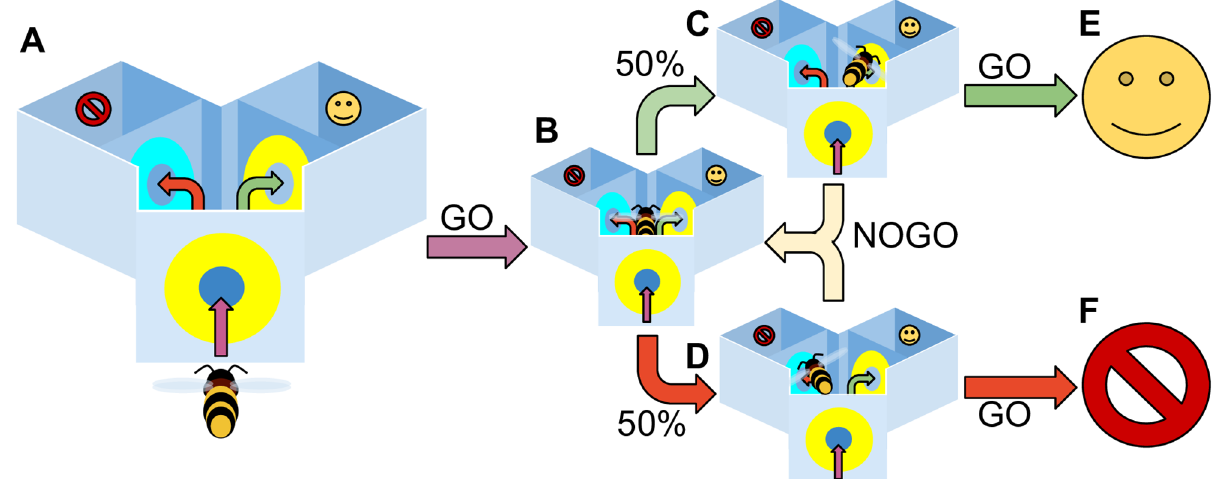
Fig 4. Experimental protocol for the model. The model bee is moved between a set of states which describe different locations in the Y-maze apparatus ( A ): at the entrance ( B ), in the central chamber facing the left arm( D ), in the central chamber facing the right arm ( D ), in the left arm or in the right arm ( E,F ). When at the entrance or in the main chamber the bee is presented with a sensory input corresponding to one of the test stimuli; GO selection leads the bee to enter the maze when at the entrance, and to enter an arm and experience a potential reward when facing that arm; NOGO leads the bee to delay entering the maze, or to choose another maze arm uniformly at random, respectively. We can then set the test stimuli presented to match the requirements of a given trial (e.g. entrance (A), main chamber left (A), main chamber right (B) for DMTS when rewarding the left arm, or DNMTS when rewarding the right